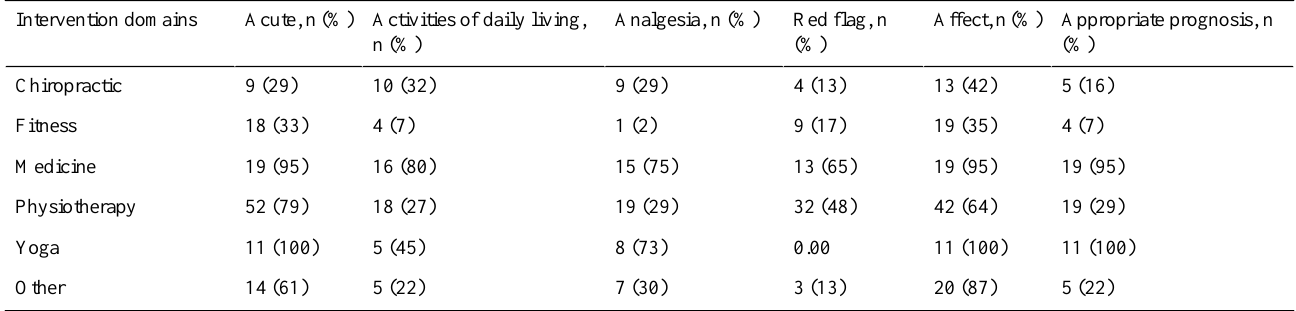
Table 4. Results of acute low back pain checklist